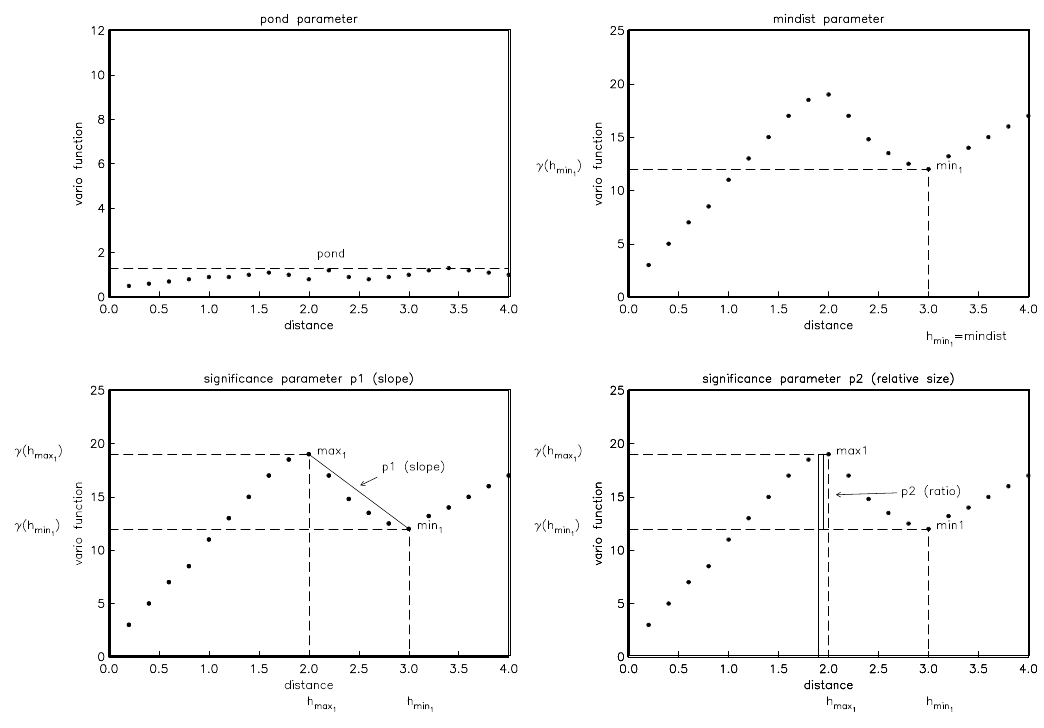
Figure 1. Vario parameters for geostatistical